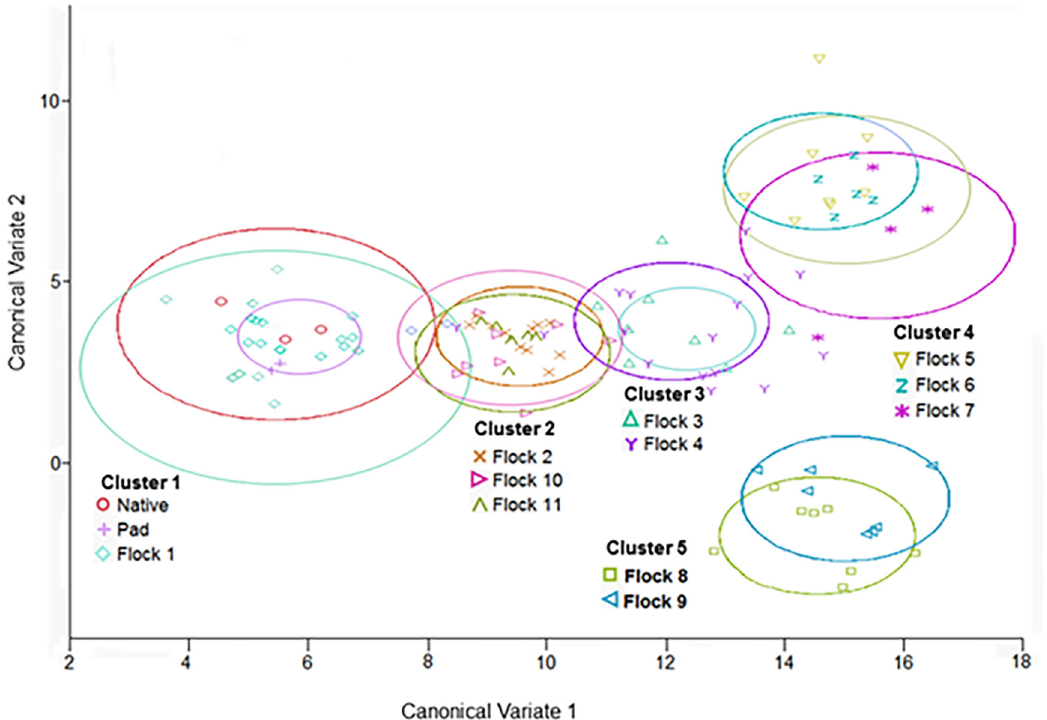
Fig 1. Canonical discriminant analysis plot of clusters from eleven flock rotations. Canonical discriminant analysis plot showing the eleven flocks separated into five discreet clusters (Cluster 1 = Native, Pad and Flock1; Cluster2 = Flock 2, 10 and 11; Cluster 3 = Flocks 3 and 4; Cluster 4 = Flocks 5, 6, and 7; Cluster 5 = Flocks 8 and 9) with the shifts between the clusters along both the Canonical Variate 1 and 2 axes.